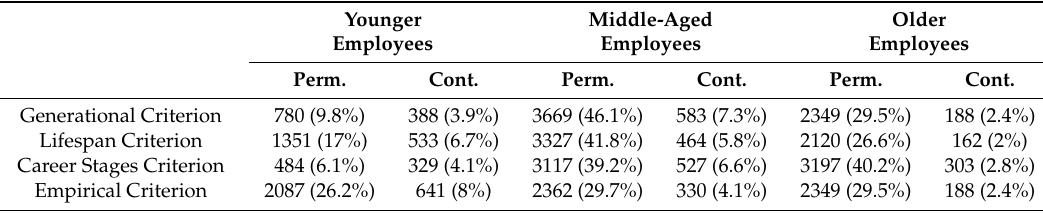
Table 3. Alternative age class*employment status classifications used for the present